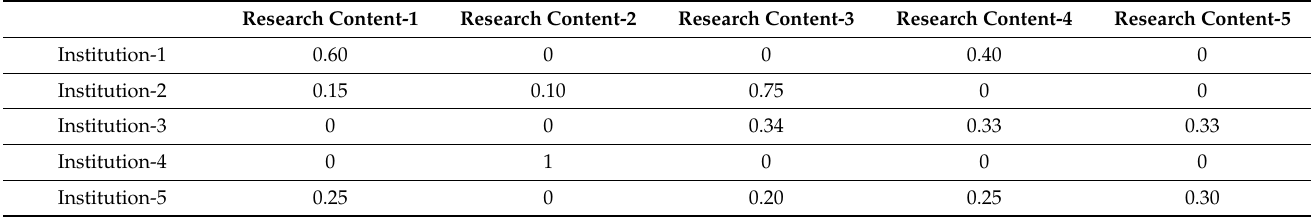
Table 3. Example of a journal—research content probability